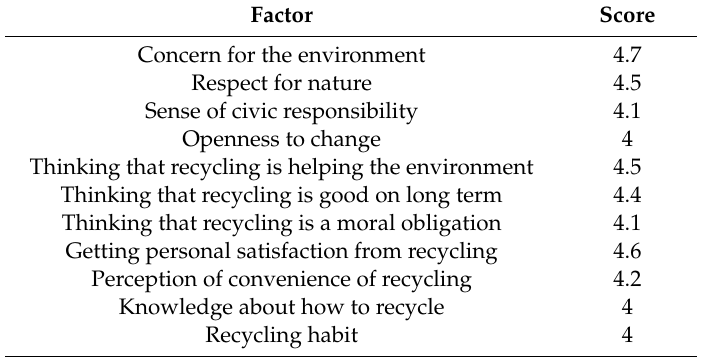
Table 3. Most relevant influencing factors for recycling behavior based on questionnaire